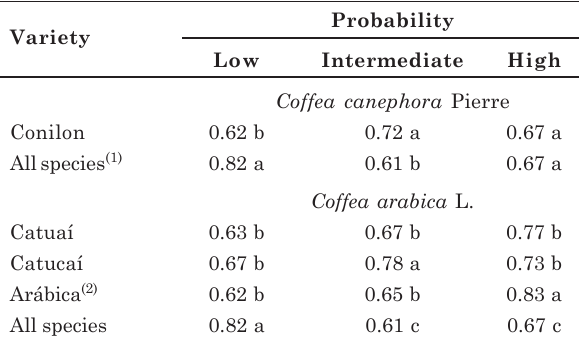
Table 6. Probability comparison of overlapping groups for foliar phosphorus and remaining phosphorus for the different combinations used in the cluster analysis